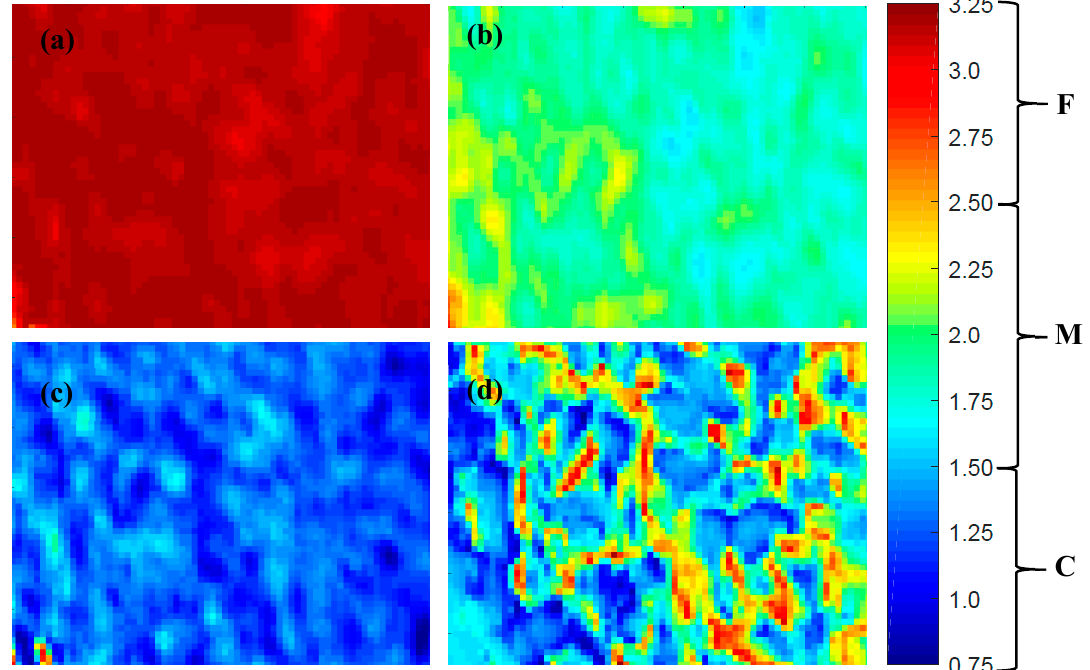
Figure 7. Example of prediction map of discrete particle fractions of milk powder ( a ) fine particle fraction sample; ( b ) medium particle fraction sample; ( c ) coarse particle fraction sample; and ( d ) recombined fractions sample.